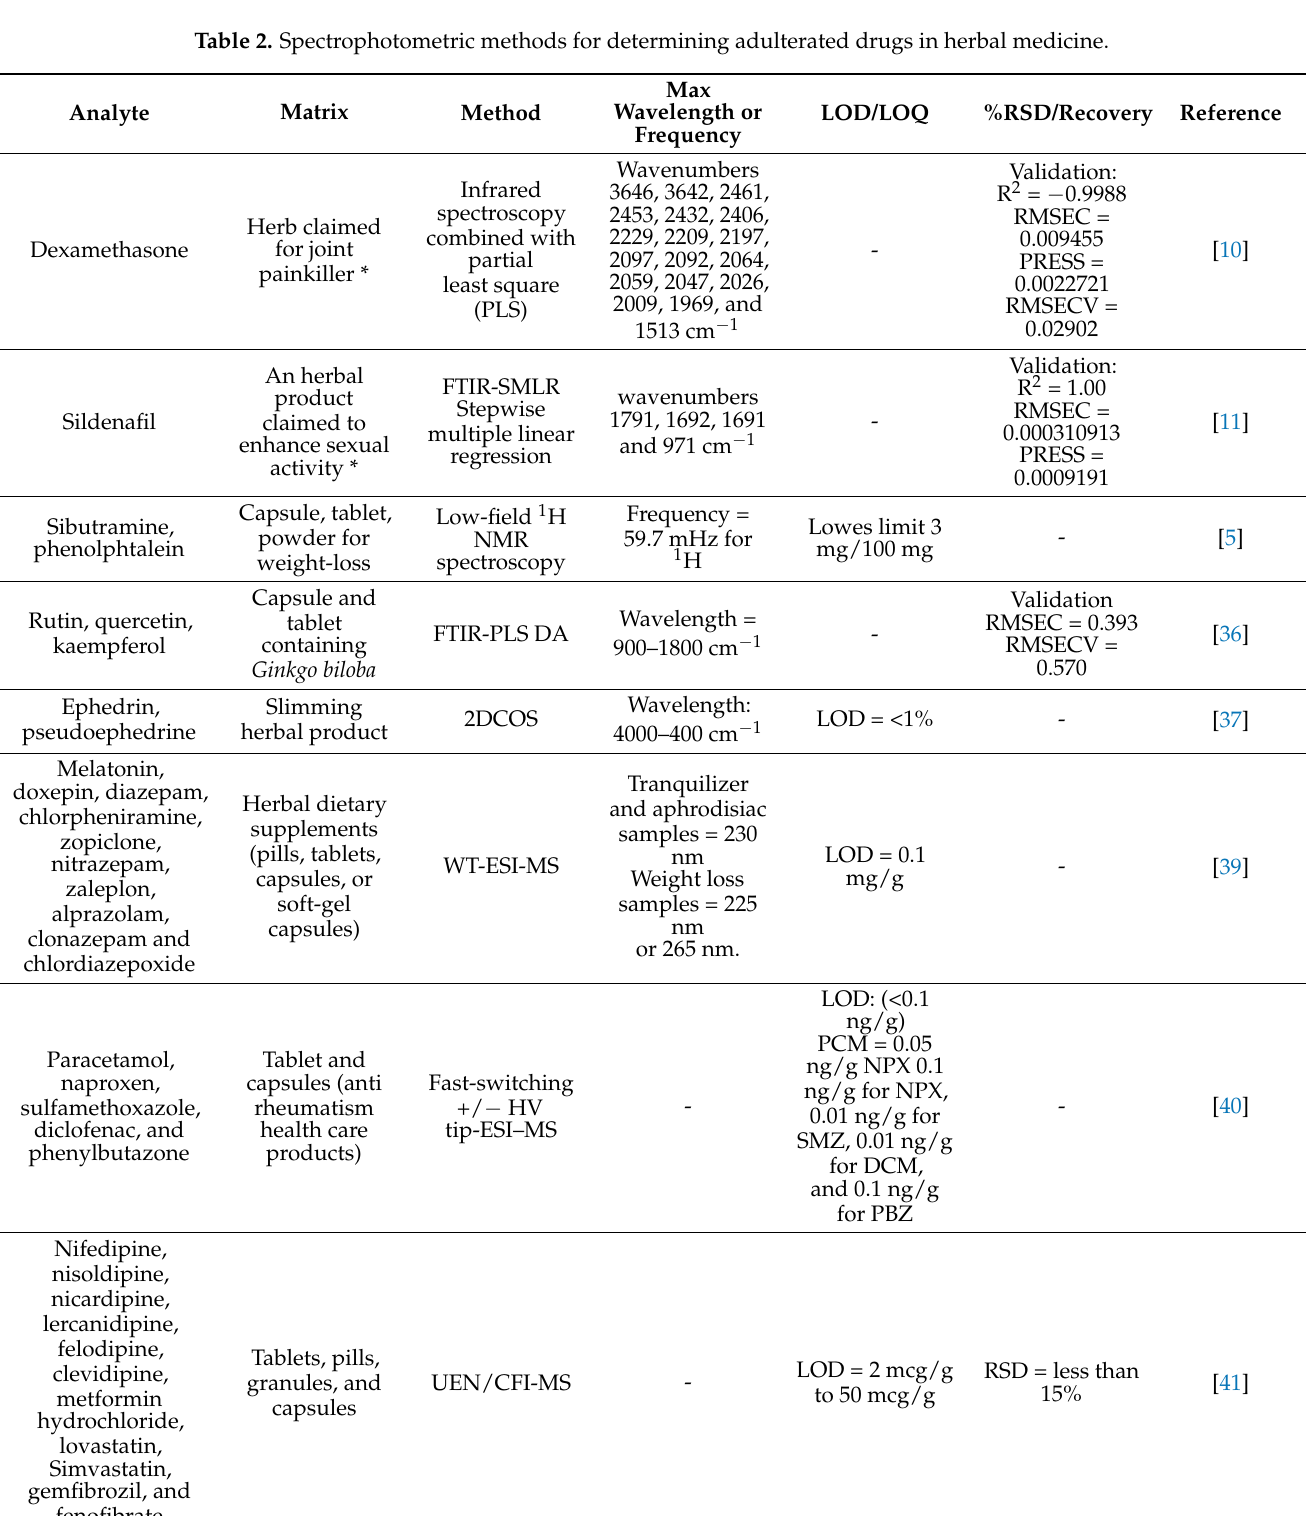
Table 2. Spectrophotometric methods for determining adulterated drugs in herbal medicine.